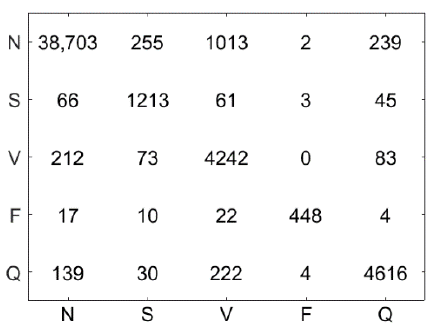
Figure 15. Confusion matrix using the CSCC model.